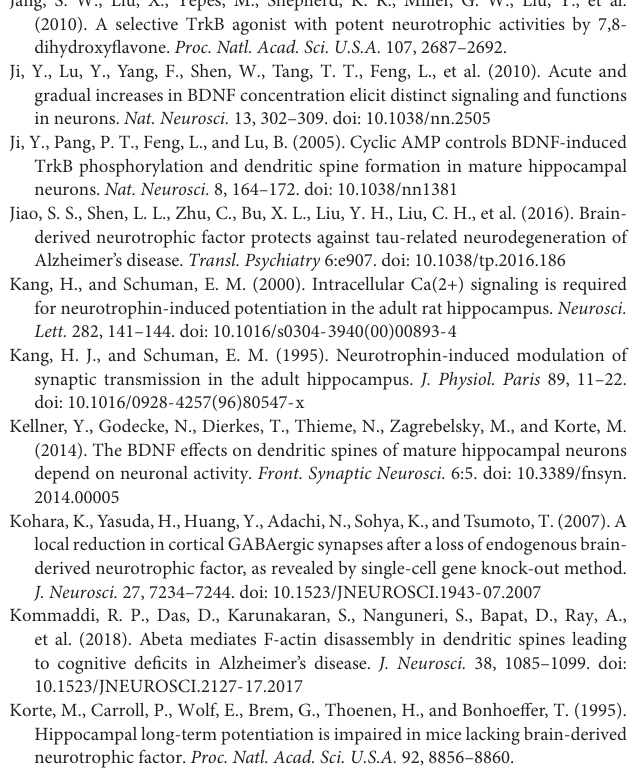
Hippocampal long-term potentiation is impaired in mice lacking brain-derived neurotrophic factor. Proc. Natl. Acad. Sci. U.S.A. 92, 8856–8860.